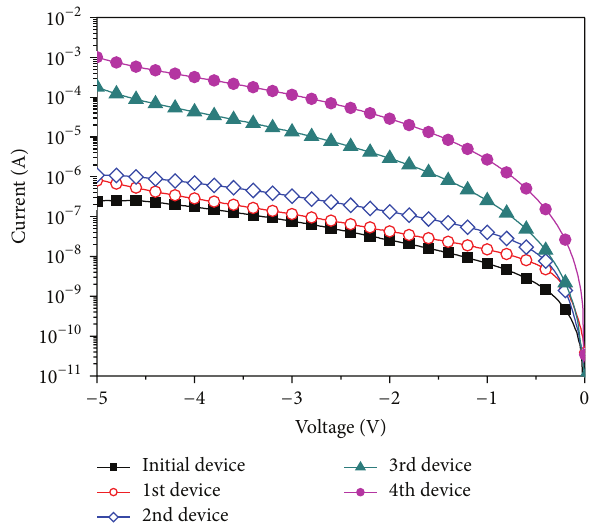
Figure 4: Reverse-bias dark I-V characteristics of the solar cells grown on new and recycled GaAs